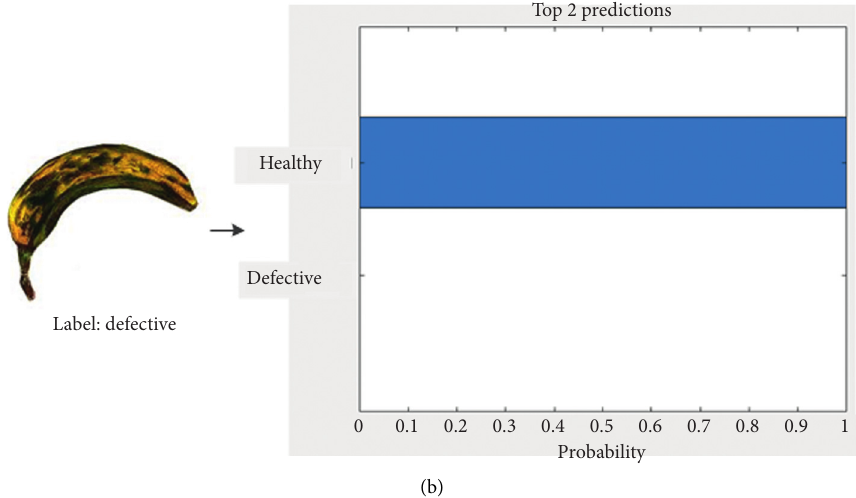
Figure 7: Samples of misclassified images.